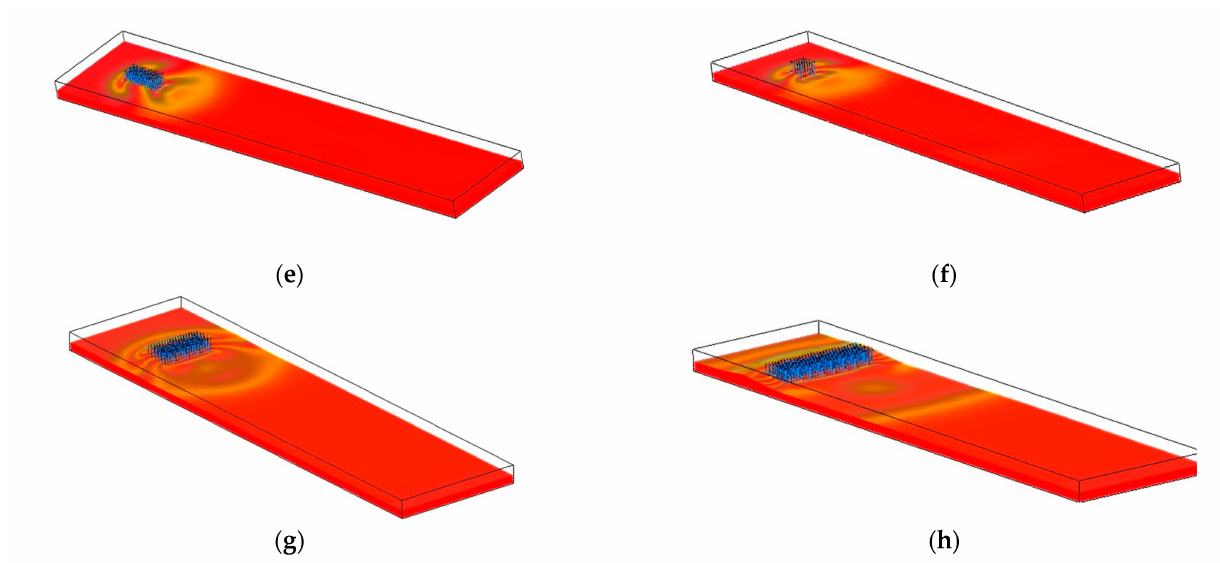
Figure 7. Two-dimensional (2D) Distribution of water–air volume fraction ( a ) Case 1, ( b ) Case 2, ( c ) Case 3, ( d ) Case 5: Three-dimensional (3D) distribution of water volume fraction ( e ) Case 2, ( f ) Case 3, ( g ) Case 4, ( h ) Case